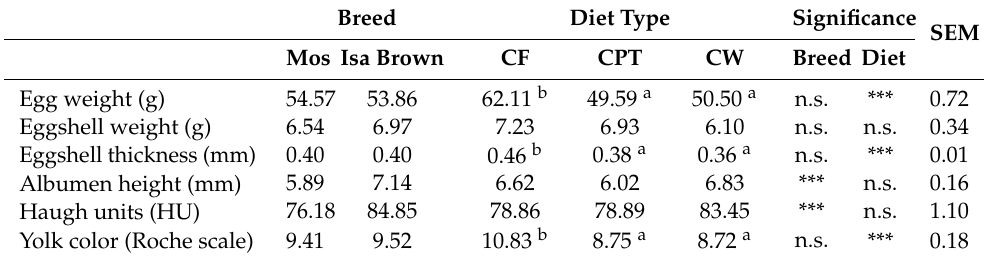
Table 2. E ff ect of breed (Mos vs. Isa Brown) and diet type (CF, CPT and CW) on egg freshness quality. Breed Diet